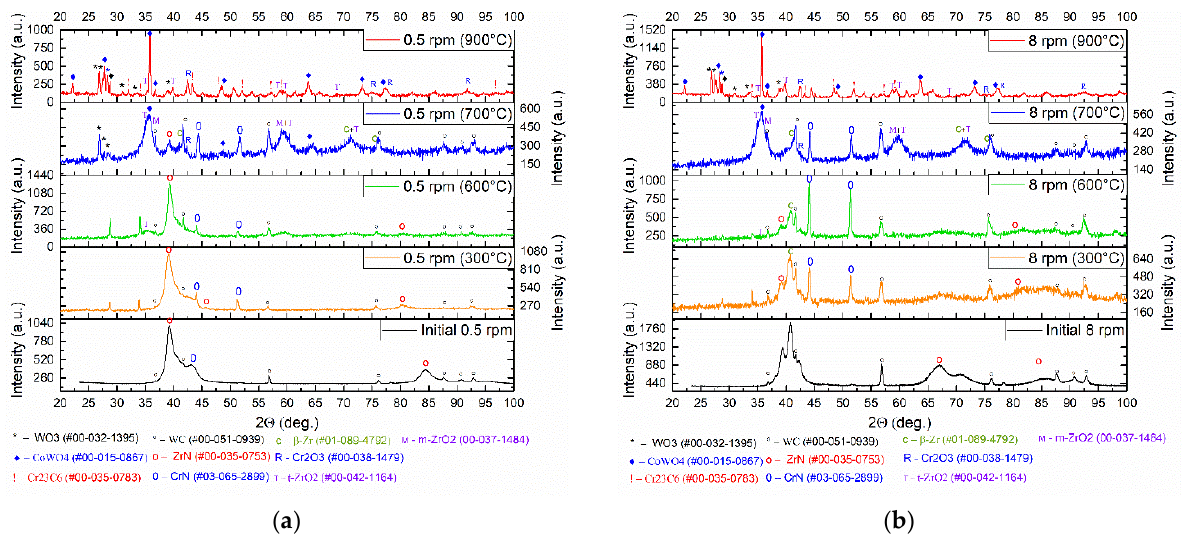
Figure 8. The difractogramms obtained from the surfaces of as-deposited and oxidized at 300, 600, 700 and 900 °C 0.5 RPM ( a ) and 8 RPM ( b ) coatings .